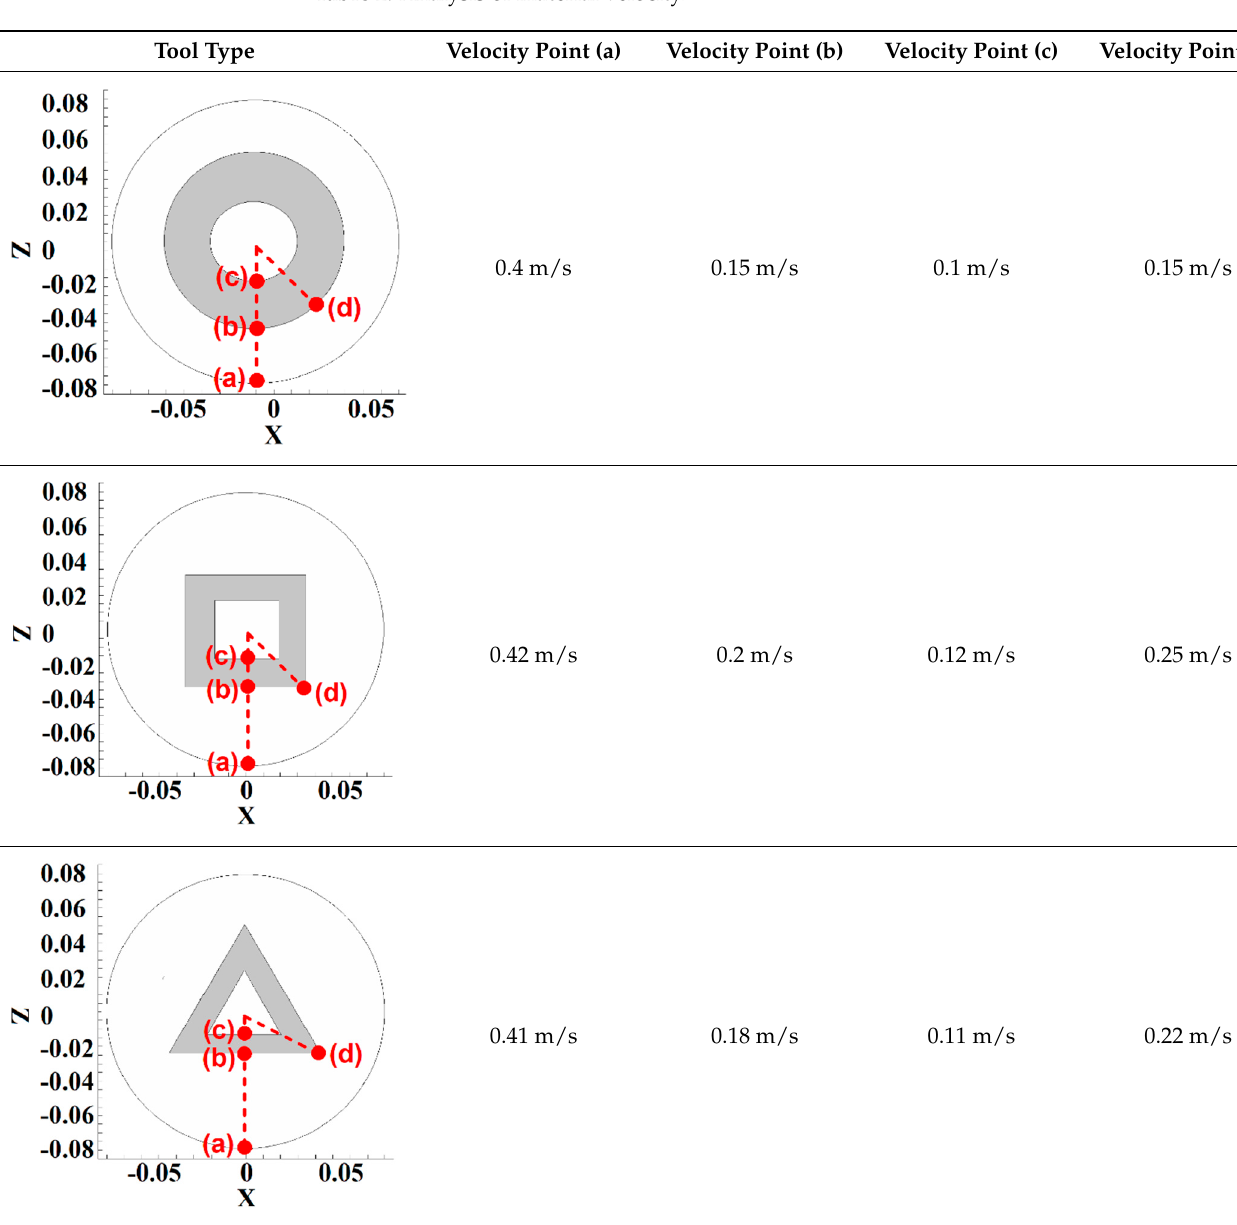
Figure 10. Internal material flow around ( a ) FPT, ( b ) TPT, and ( c ) CPT pins. Internal flow path of joints welded by ( d ) FPT, ( e ) TPT, and ( f ) CPT pins. Four points in the stir zone were selected for a better analysis of material velocity. The selected point’s positions from the top view are depicted in Table 2. One point was selected at the exterior area of the tool shoulder (point (a)), one point was selected at the interface of shoulder and pin (point (b)), one point was selected at the pin bottom (point (c)), and the last point selected at pin edges at the interface of the pin–shoulder surface (point (d)). The results of the HDPE velocity simulation are presented in Table 2. From the